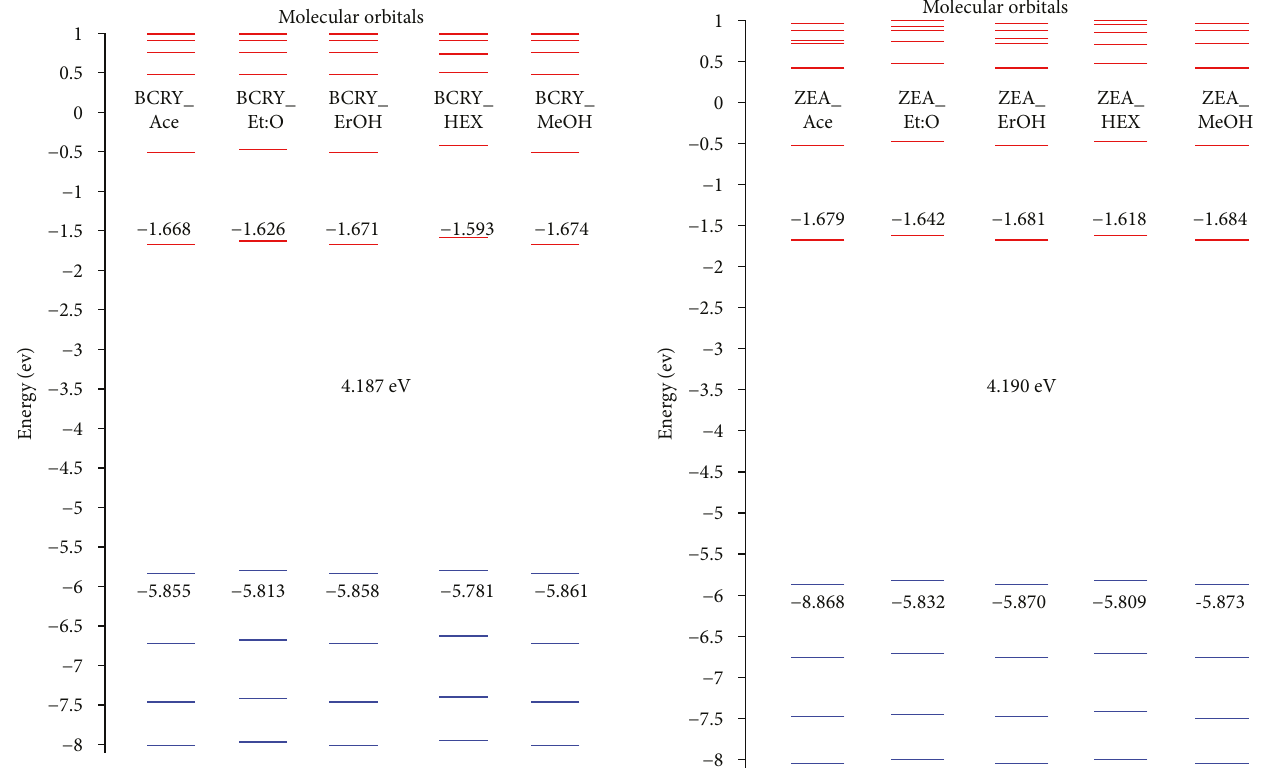
Figure 7: Molecular orbital energies (eV) of combinations in the ground